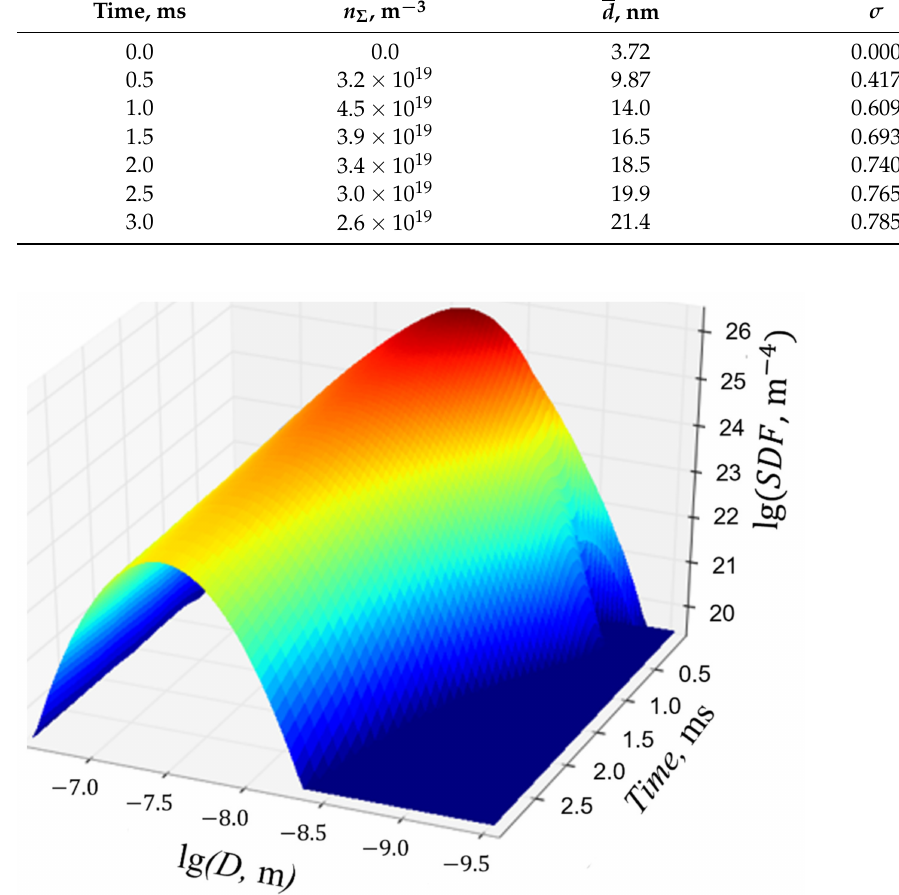
Figure 5. Time evolution of the soot-particle log-normal SDF for the n-heptane–air mixture at Φ = 4, p = 10 atm, T = 2000 K, and EGR =